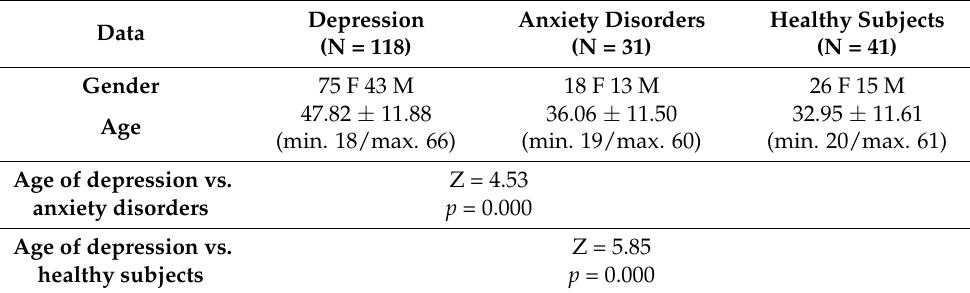
Figure 2. The duration of illness. Table 1. Characteristics of the study